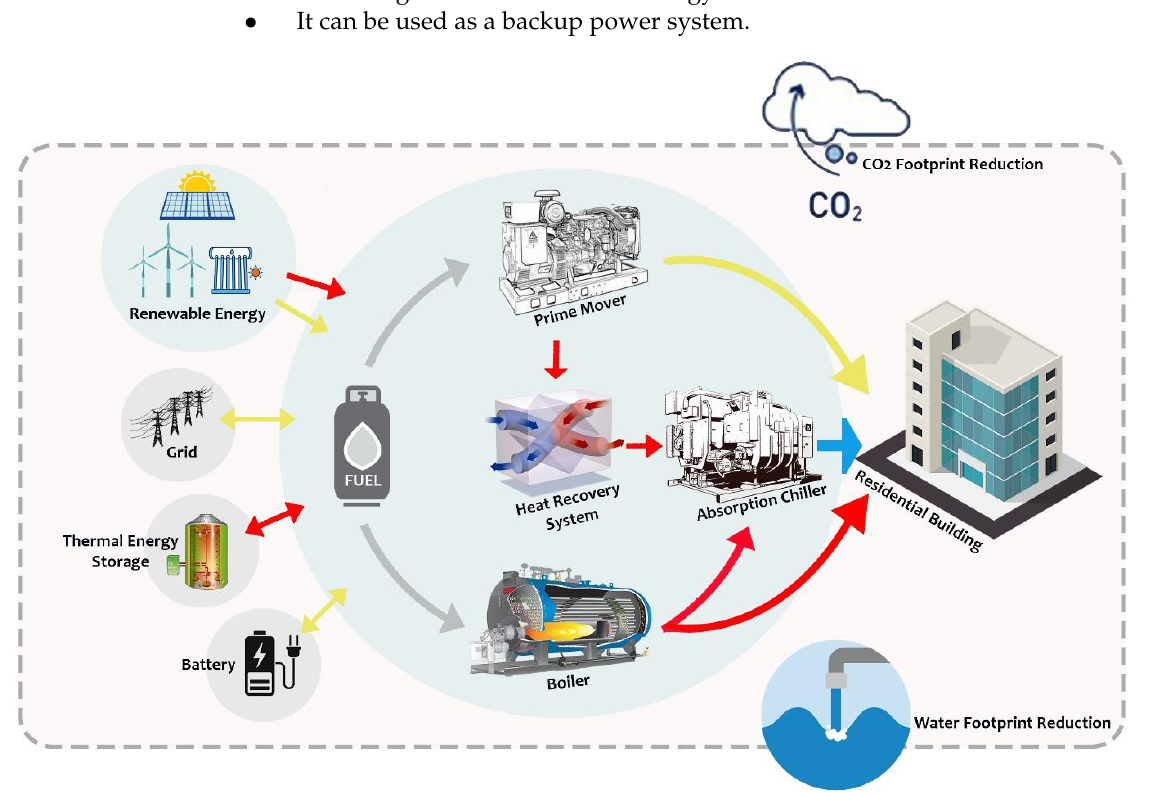
Figure 1. Multi-functional CCHP with application in the residential sector.